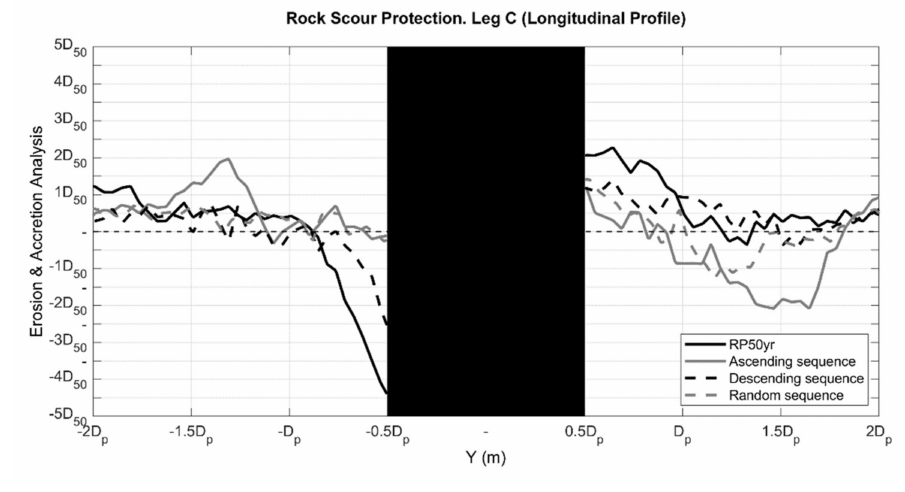
Figure 13. Leg C: longitudinal profile.